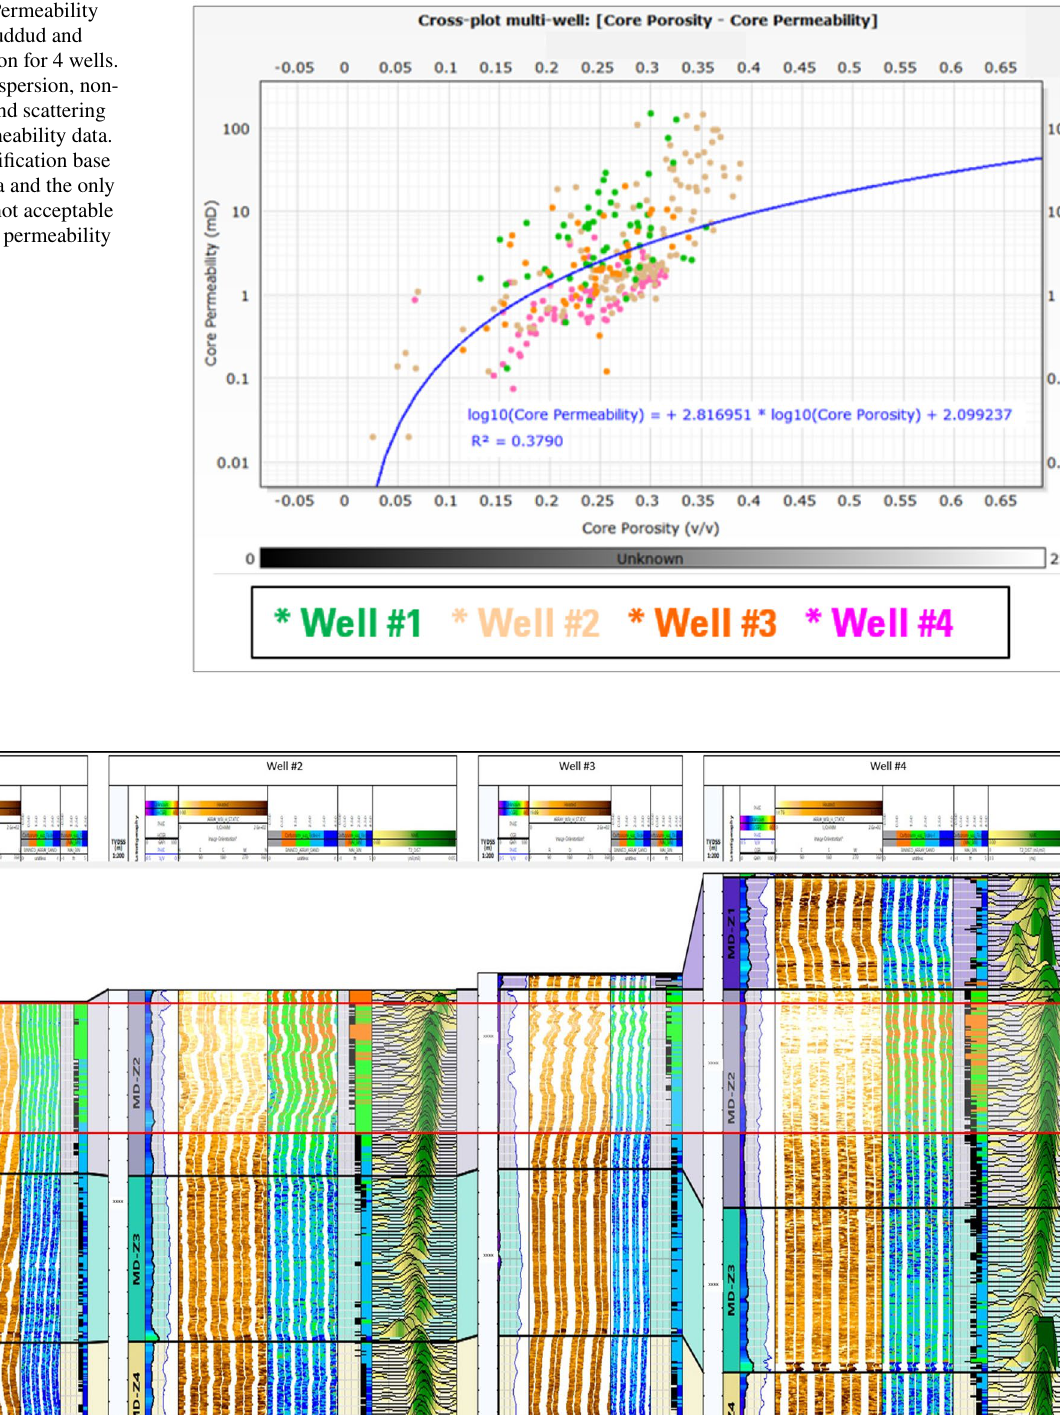
Fig. 4 Porosity Permeability transform in Mauddud and Shuaiba Formation for 4 wells. Note Irregular dispersion, non- categorization, and scattering of porosity–permeability data. There is no classification base on quality of data and the only classification is not acceptable for quality of the permeability